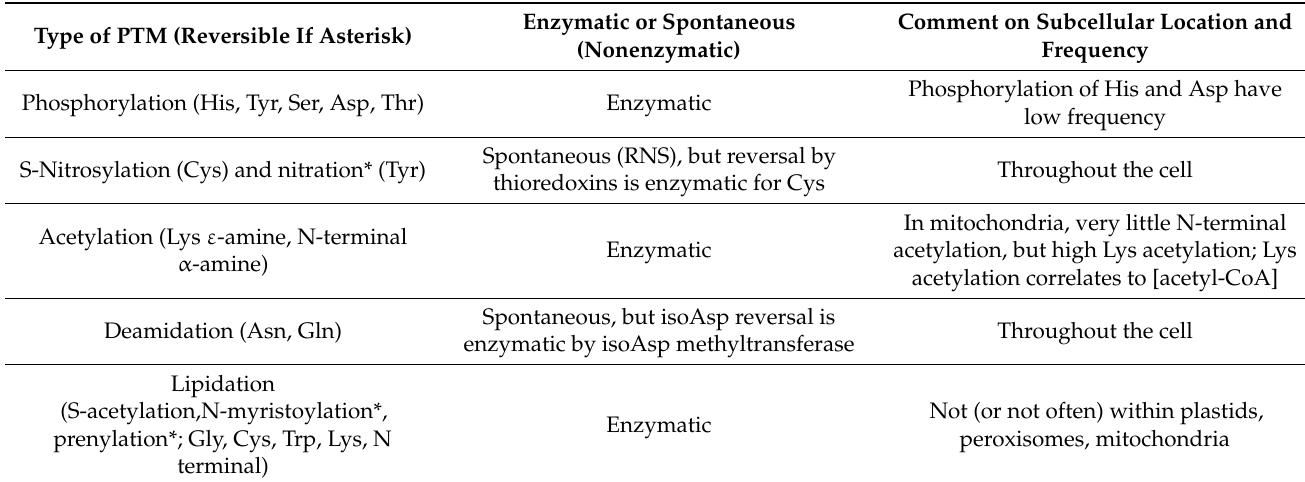
Table 3. The most critical posttranslational modifications detected in plants